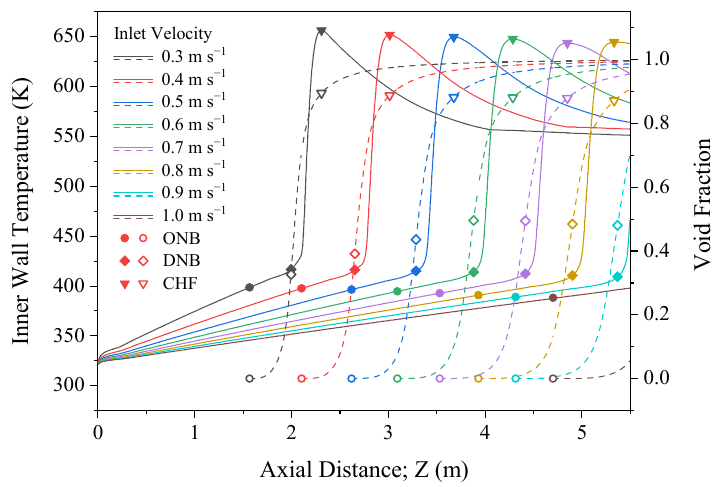
Figure 15. Inner wall temperature distributions along the axial direction at inlet velocities of 0.3 m · s − 1 to 1.0 m · s − 1